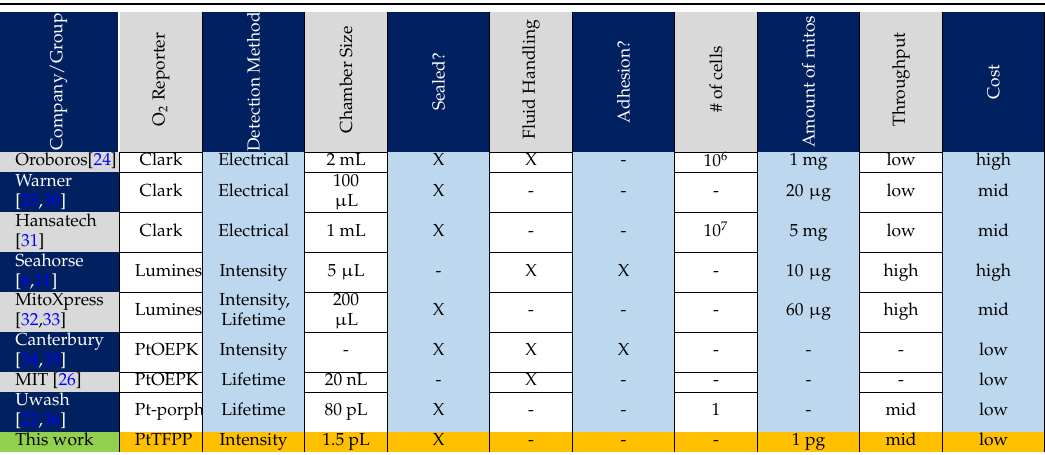
Table 1. Comparison to selected current